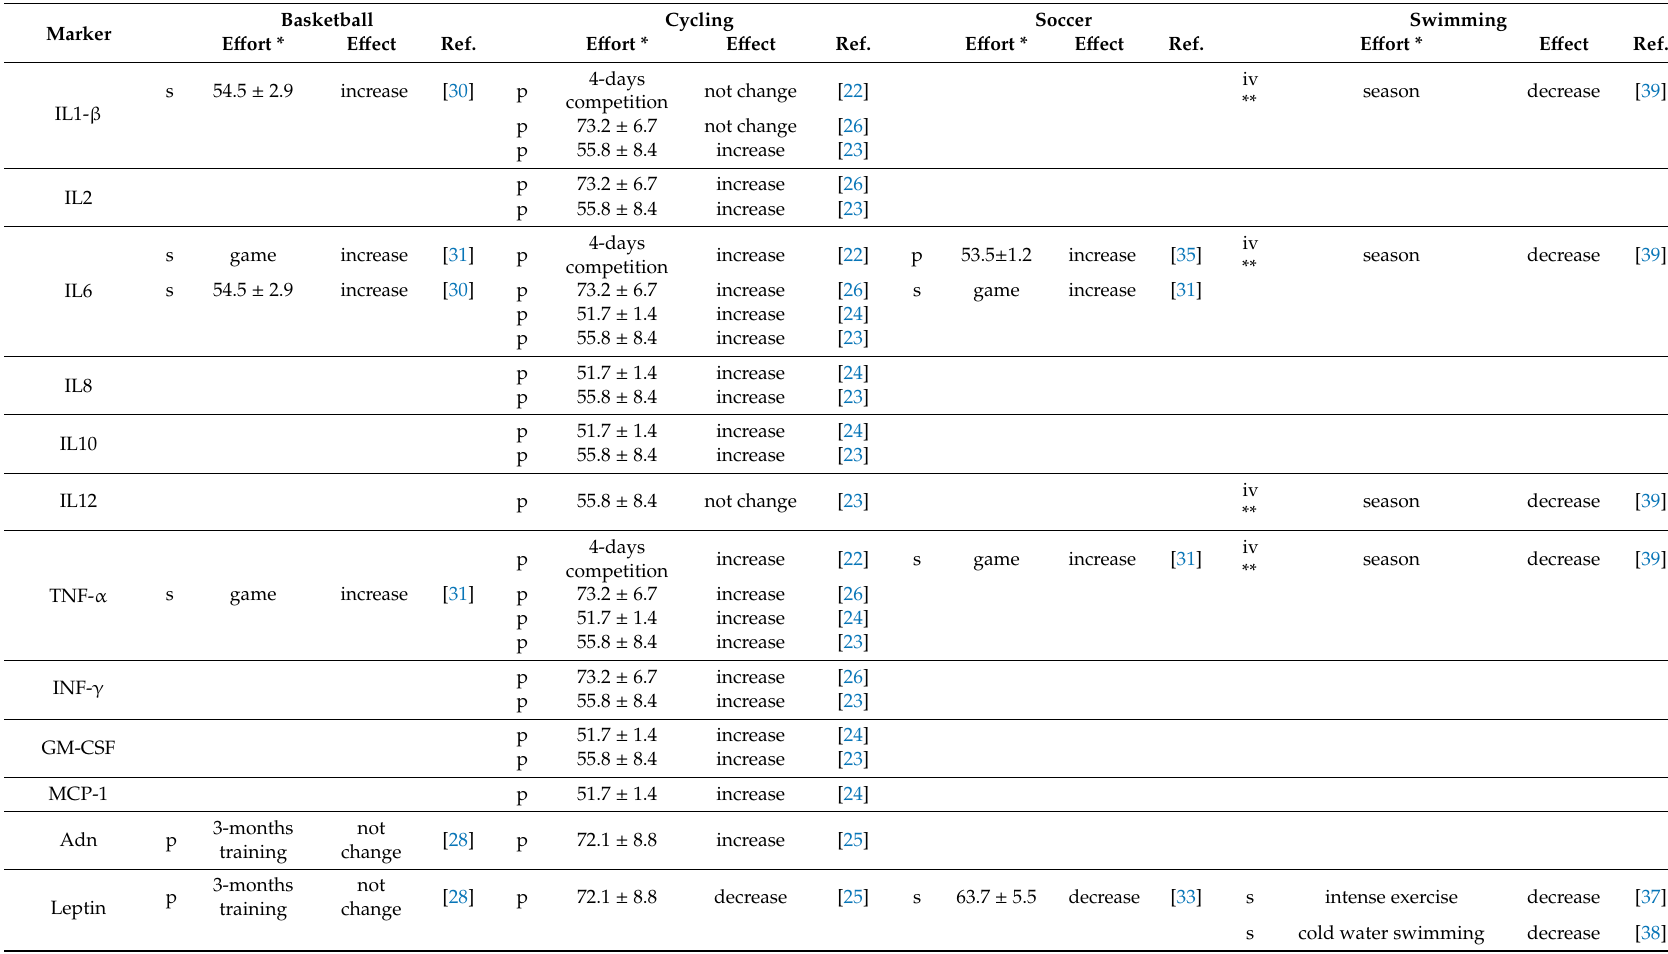
Table 1. Inflammation marker measured in cycling, basketball, soccer and